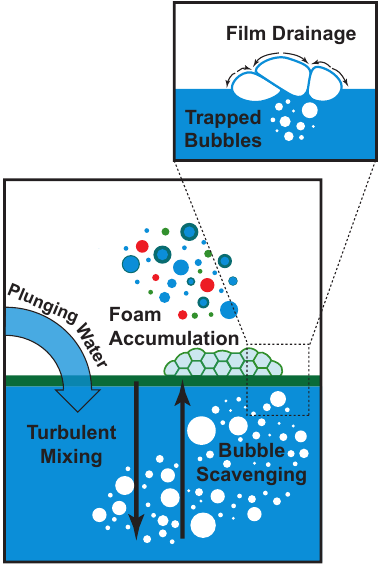
Figure 9. Process diagram of SSA production depicting phenomena described in Sect.